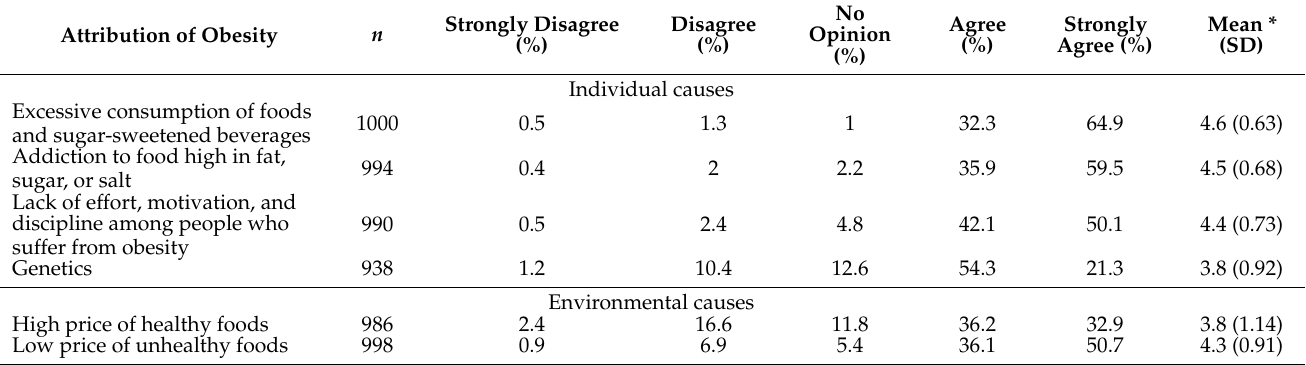
Table 2. Degree of agreement with attribution of obesity to individual and environmental causes.